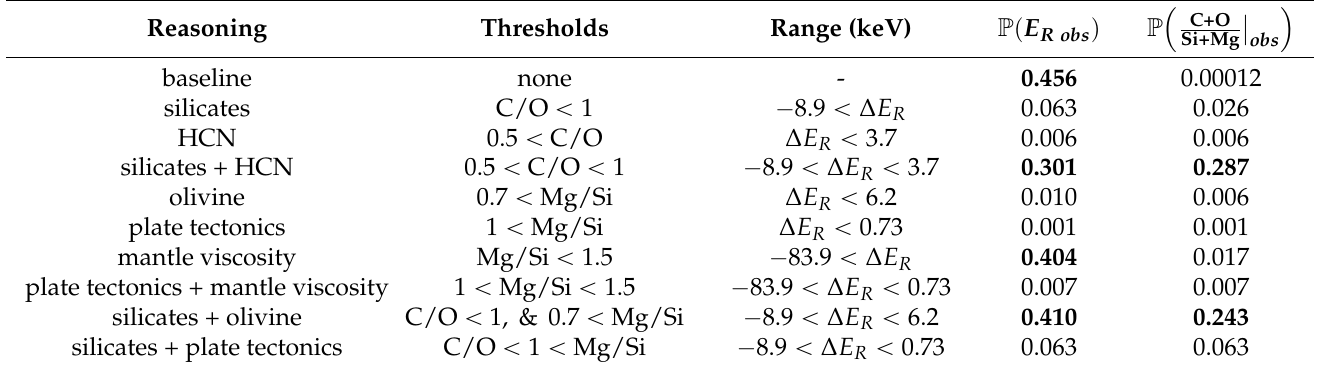
Table 3. The probabilities of our observations for various habitability criteria described in the main text. Each row indicates a purported habitability criterion (or combination), the associated restrictions on elemental abundance ratios, and the range of Hoyle resonance energies compatible with those restrictions. P p E R obs q is the probability of observing the Hoyle resonance energy to be at least as small q is the probability of measuring the ‘organic-to-rock’ as our measured value, and P p (C+O)/(Si+Mg) obs ratio to be at least as large as our measured value. Probabilities greater than 0.1 are displayed in bold. All probabilities are computed utilizing the entropy and yellow habitability